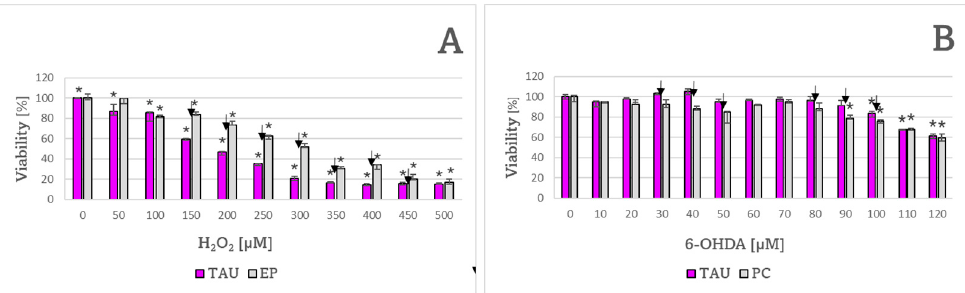
Figure 7 . Sensitivity of TAU and EP cells to H 2 O 2 and 6-OHDA. TAU cells were significantly more sensitive to H 2 O 2 at concentrations ranging from 150 to 500 μ M ( A ) and more resistant to 6-OHDA at concentrations of 30 to 50, and 80 to 100 μ M compared to EP controls ( B ). * p < 0.05 with respect to cells not treated with H 2 O 2 or 6-OHDA. ↓ p < 0.05, TAU compared to EP (cells treated with the same concentration of H 2 O 2 or 6-OHDA); n = 3.